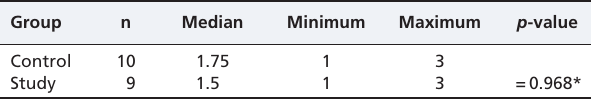
Table 6 - Vessel inflammation/diameter analysis among the groups.